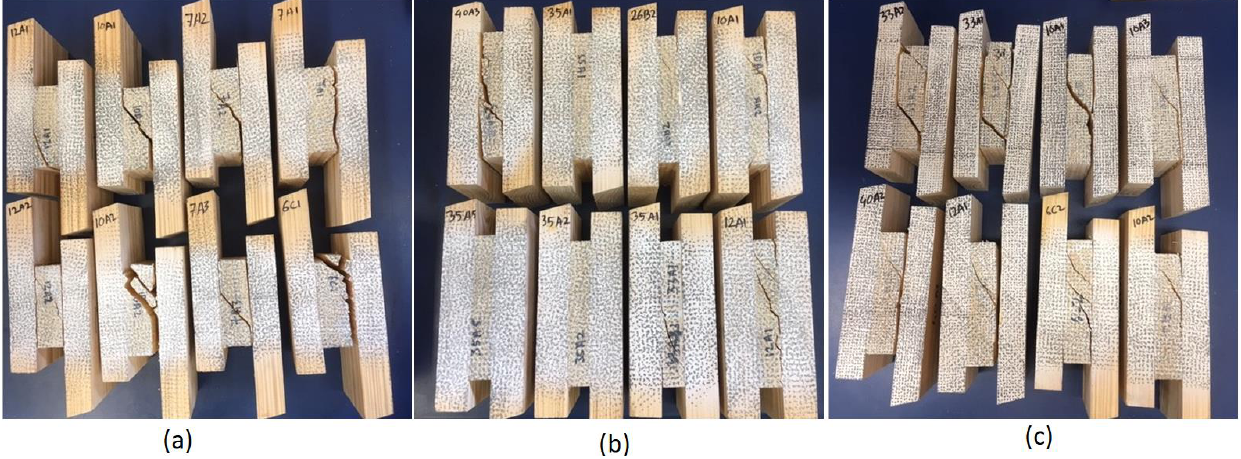
Figure 12. Example of ( a ) 3.0, ( b ) 6.75 and ( c ) 4.5 aspect ratio failure modes.